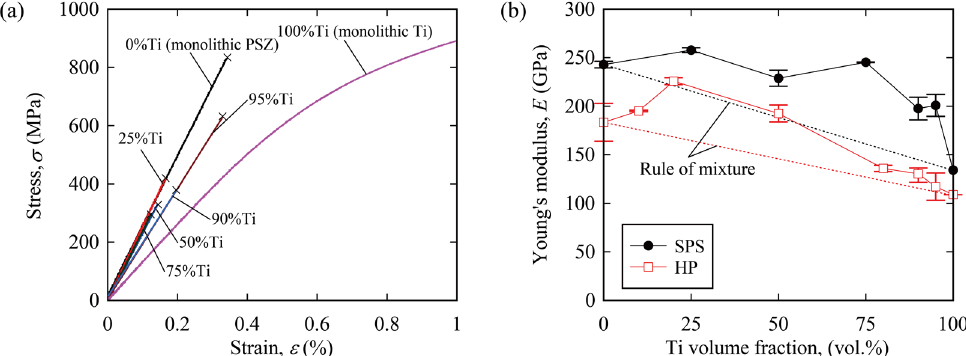
Figure 2. Mechanical properties of PSZ-Ti composites fabricated via powder metallurgy technique [15]. ( a ) Bending stress–strain curves of composites with various volume fractions of Ti fabricated via SPS; ( b ) Young’s modulus as a function of volume fraction of Ti for composites obtained via HP and SPS.